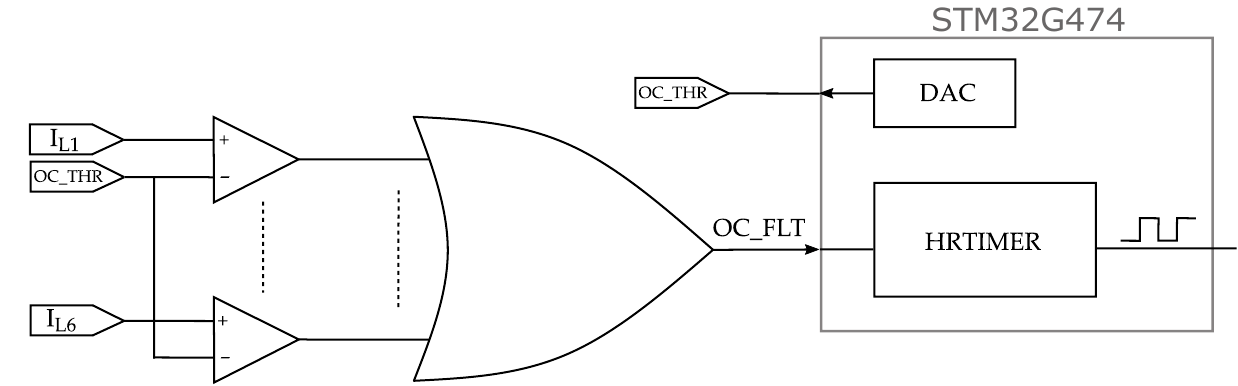
Figure 8. Overcurrent fault protection equivalent logical